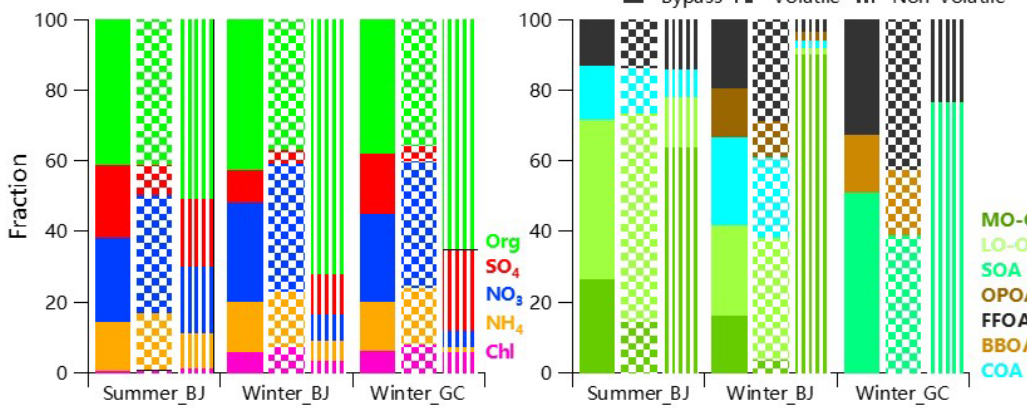
Figure 4. Average composition of total, volatile and nonvolatile PM and OA in Beijing and